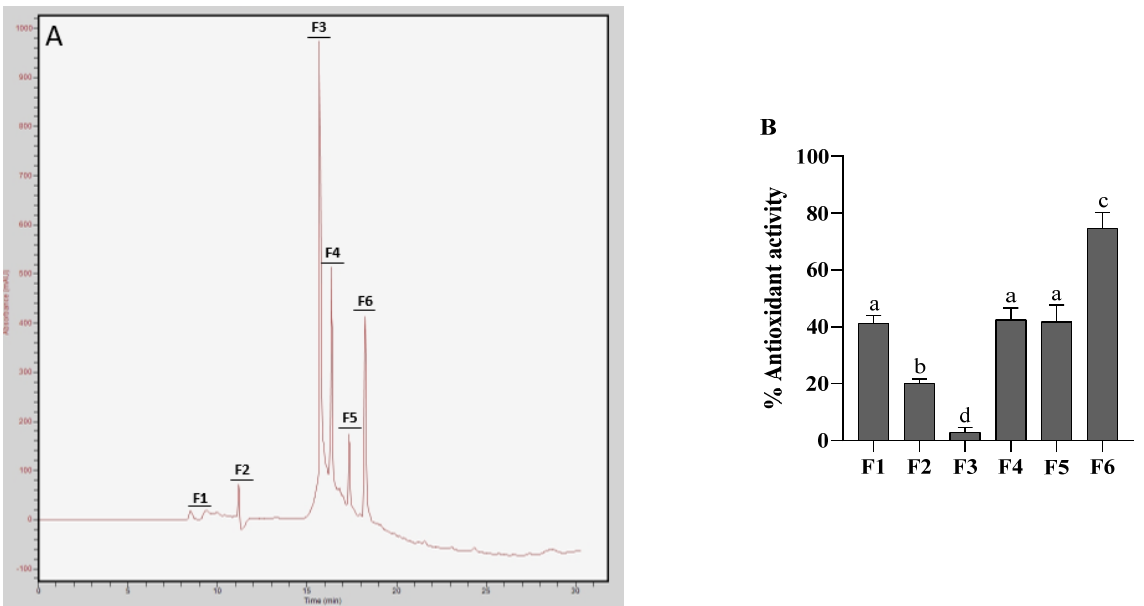
Figure 2. Purification of hydrolysate from trypsin fraction E4-T (MW < 3 kDa) by RP-HPLC on a Thermo C18 column ( A ), and chemical antioxidant activities of corresponding subfractions ( B ). Values were expressed as mean ± SD from triplicate experiments. Bars with different letters in the same group indicated statistical differences ( p < 0.05, Duncan’s test).